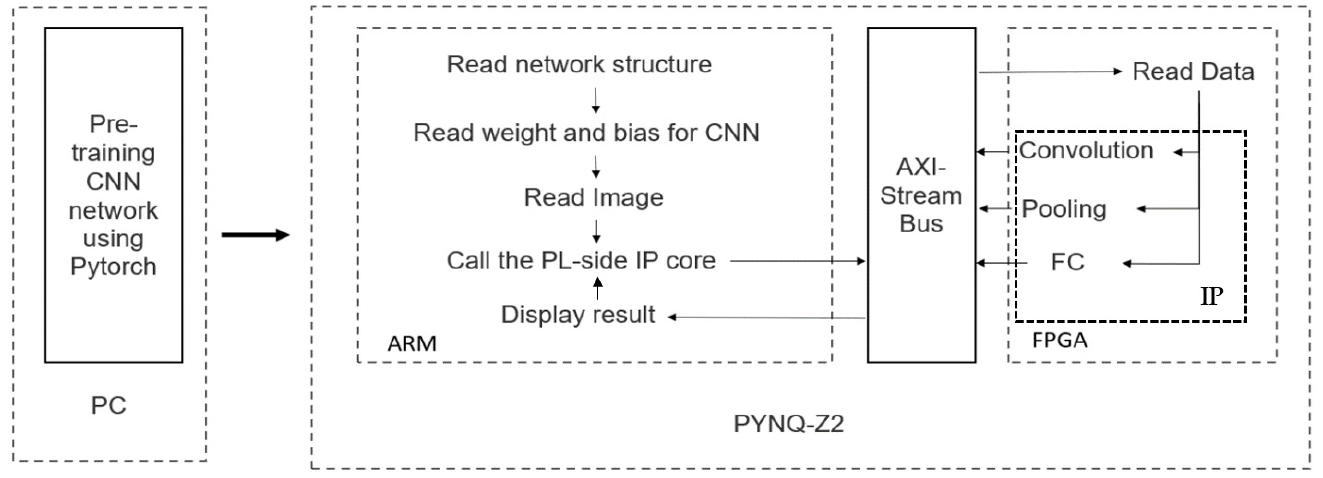
Figure 7. The overall design of the